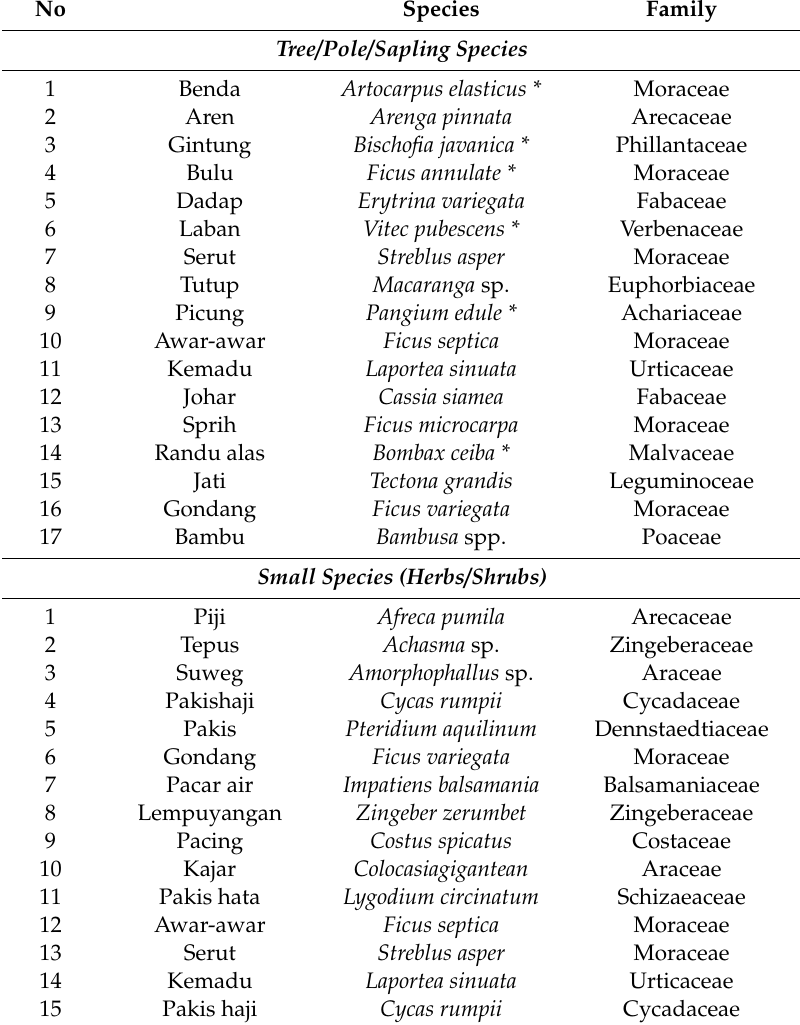
Table 2. Summary of species commonly grown around water source areas before vegetation change in both Watujali and Silengkong